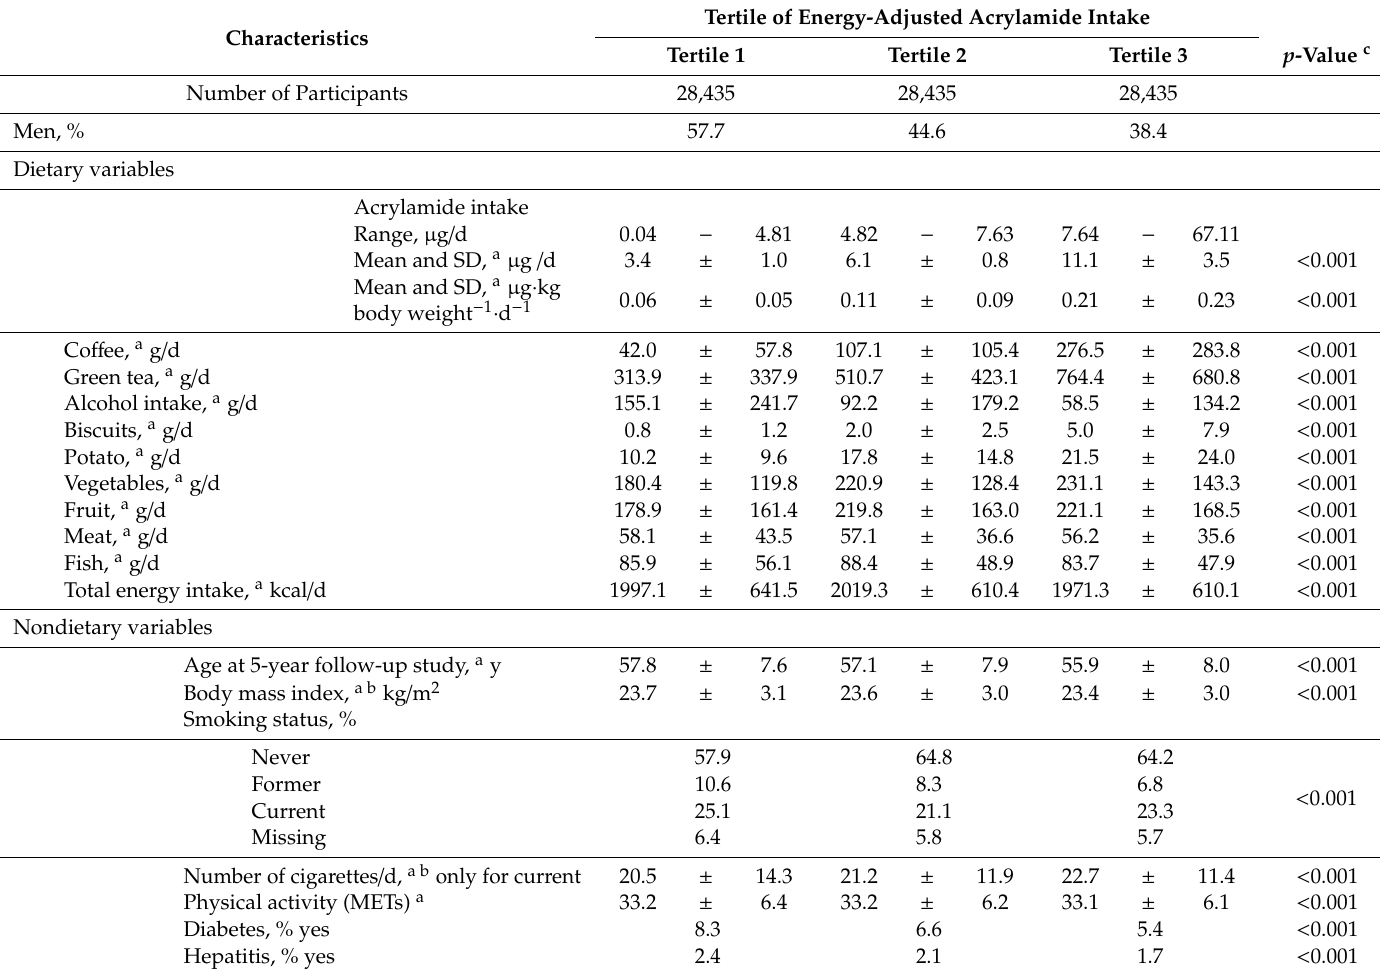
Table 1. Characteristics of participants ( n = 85,305) according to tertile of energy-adjusted acrylamide intake at five-year-study